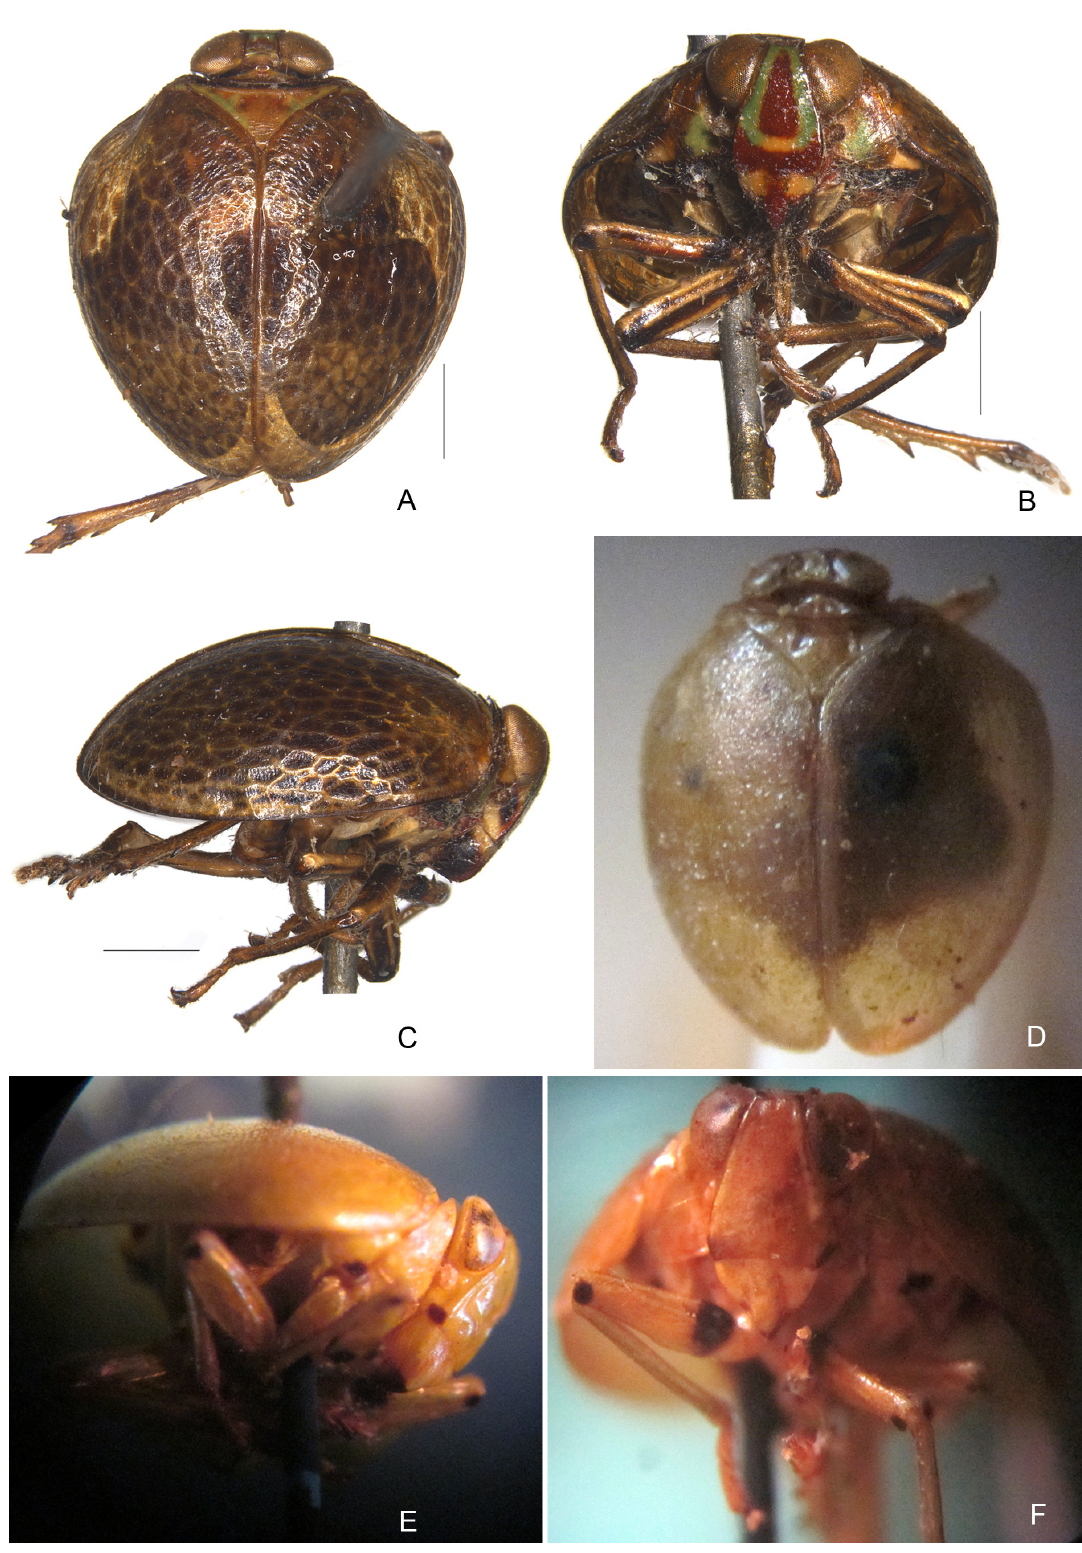
Fig. 5. Gergithus spp. A–C . Gergithus sp. A . Habitus, dorsal view. B . Habitus, frontal view. C . Habitus, lateral view. — D–F . Gergithus cribratus Melichar, 1906 . D . Habitus, dorsal view. E . Habitus, lateral view. F . Frons and clypeus, facial view. Scale bars =